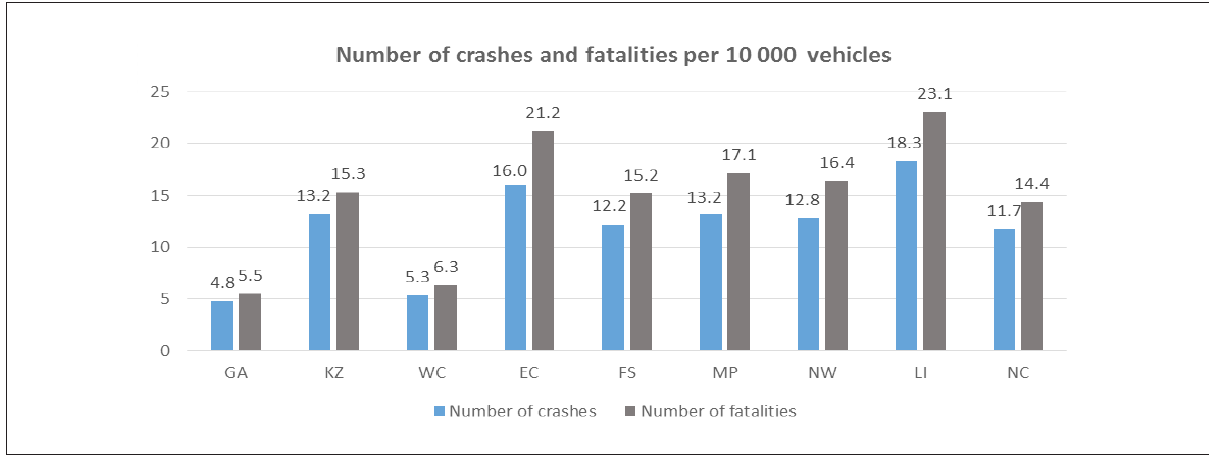
Number of crashes and fatalities per 10 000 vehicles per